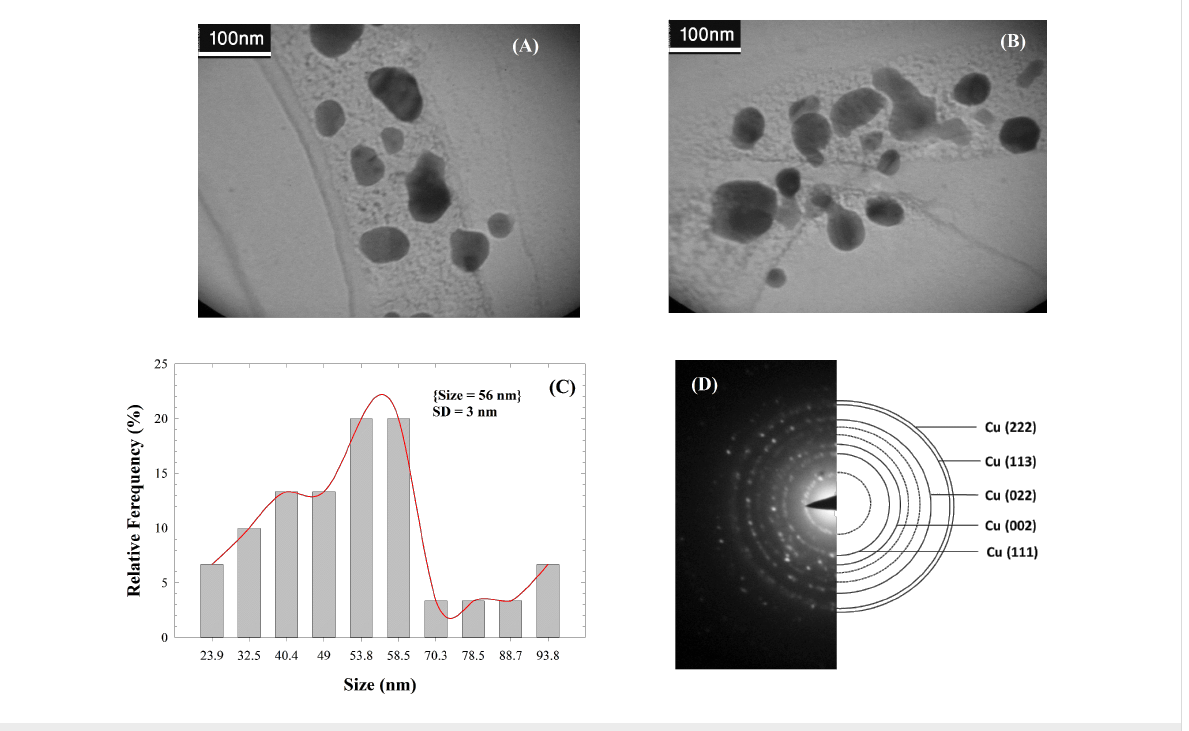
Figure 6: Typical TEM images of Cu NPs/bentonite (a,b), the histogram of the particle size distribution of Cu nanoparticles on the bentonite surface (c) and corresponding SAED pattern (d).